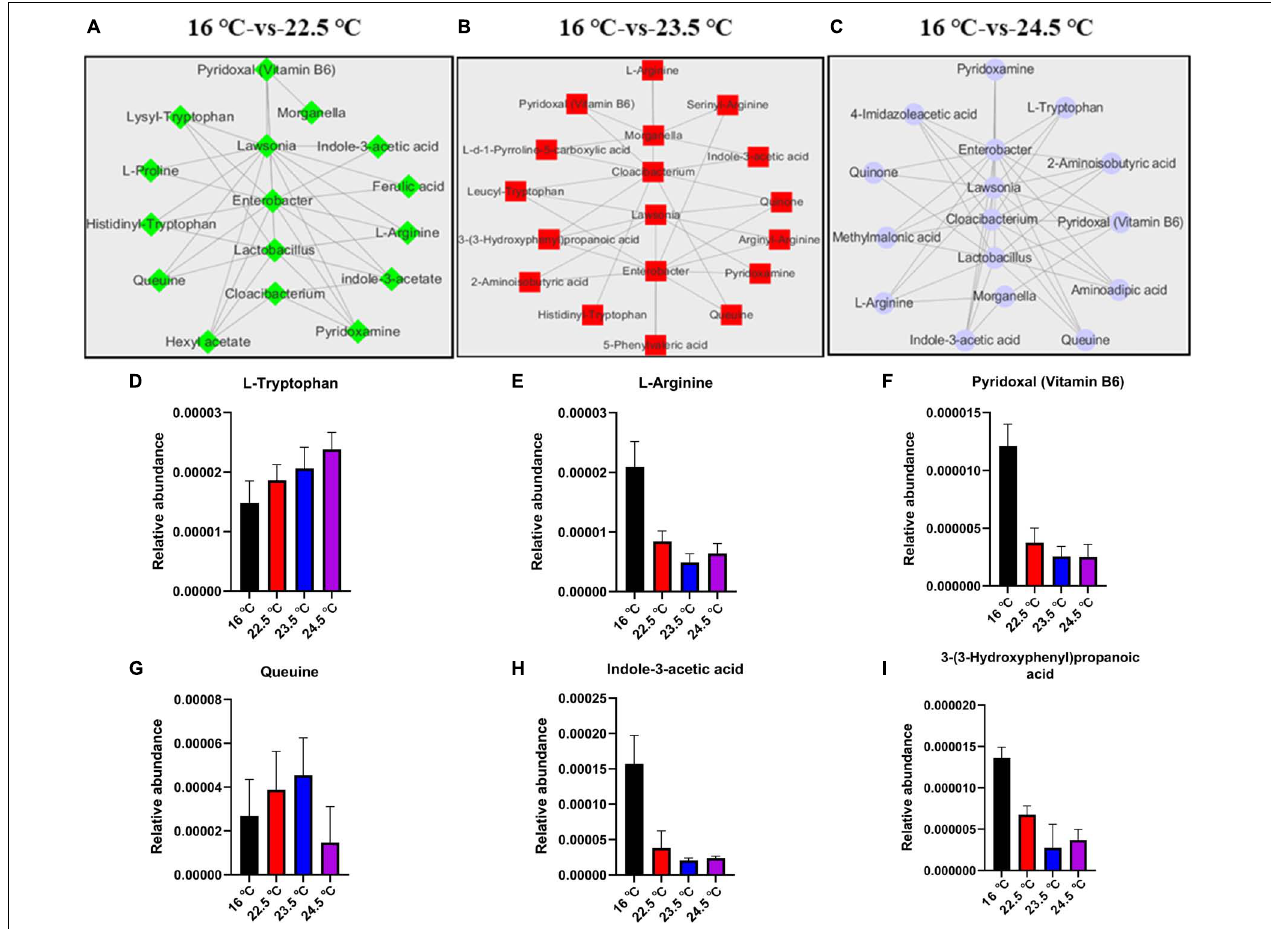
FIGURE 6 | Associations of intestinal microbiome with serum metabolites in rainbow trout under acute heat stress. (A–C) . The correlation network analysis of 16 ◦ C-vs-22.5 ◦ C, 16 ◦ C-vs-23.5 ◦ C, and 16 ◦ C-vs-24.5 ◦ C, respectively. (D–I) . Histogram of relative abundance of some metabolites in serum.